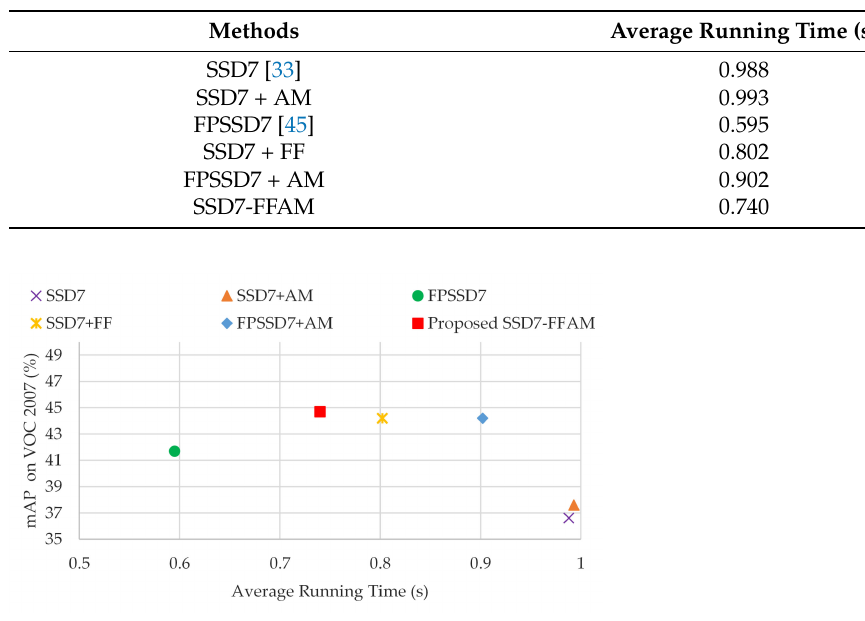
Table 3. The average running time of different networks on the Pascal VOC 2007 test set.